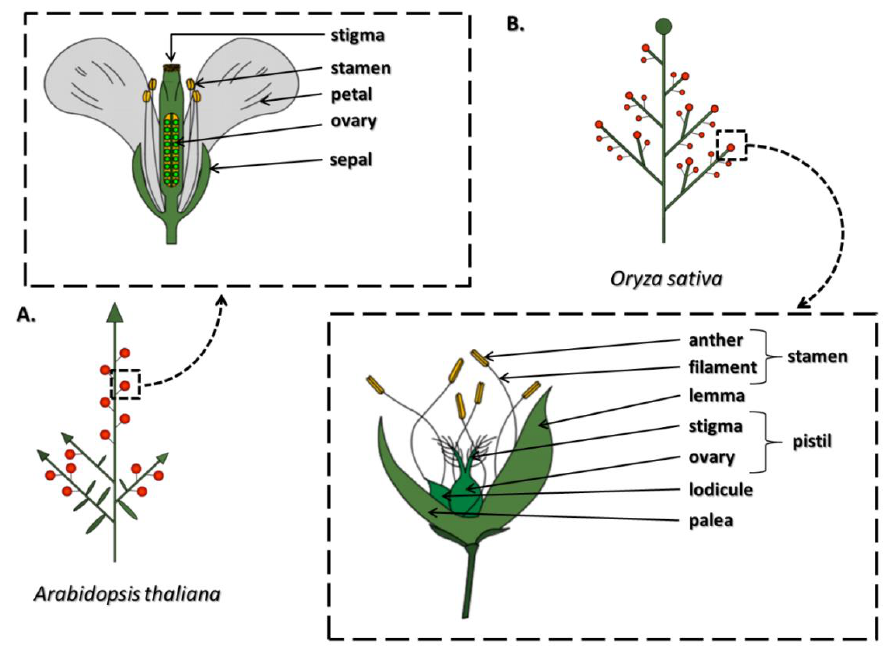
Figure 1. The inflorescence architecture and flower structure in the model dicotyledonous species Arabidopsis thaliana ( A ) and in the model monocotyledonous species Oryza sativa (rice) ( B ) According to [1,3–5].